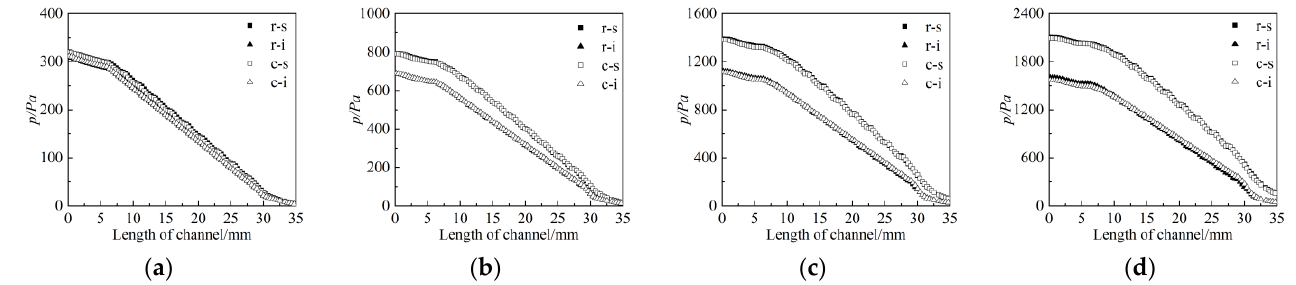
Figure 7. Pressure along the microchannel with four types of micro-pin-fin array at Re of ( a ) 50, ( b ) 100, ( c ) 150 and ( d ) 200 .